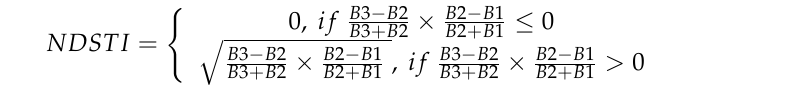
Table 3. The statistical analysis for brightness temperature (°C) and normalized difference of seasonal brightness temperature index (NDSTI) of the built-up area and non-built-up area. Student’s Built-Up Area Non-Built-Up Area t